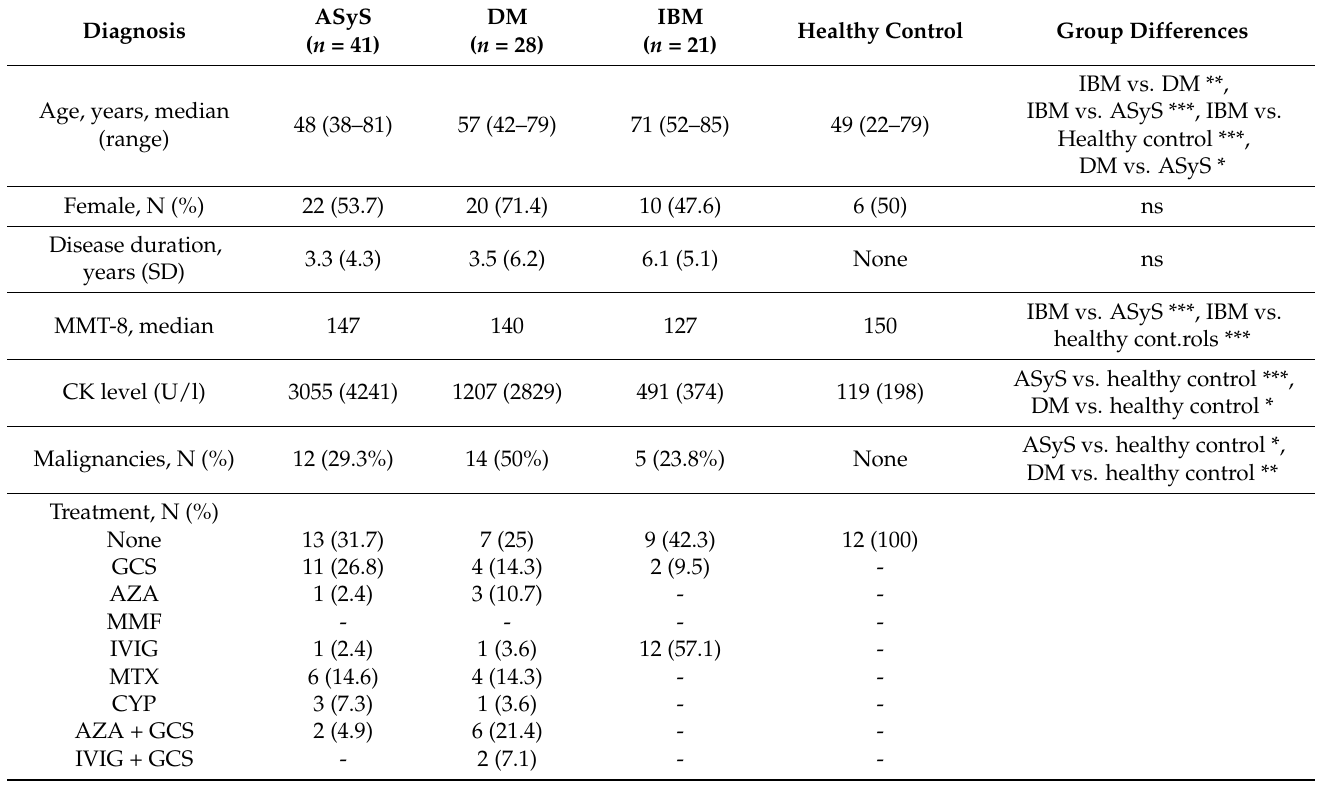
Table 1. Demographics and baseline disease characteristics. Disease duration was defined as the timespan between symptom onset and the date of blood acquisition. For group comparisons a χ 2 -test for categorial or a Kruskal–Wallis analysis of variance with post hoc Bonferroni-testing for